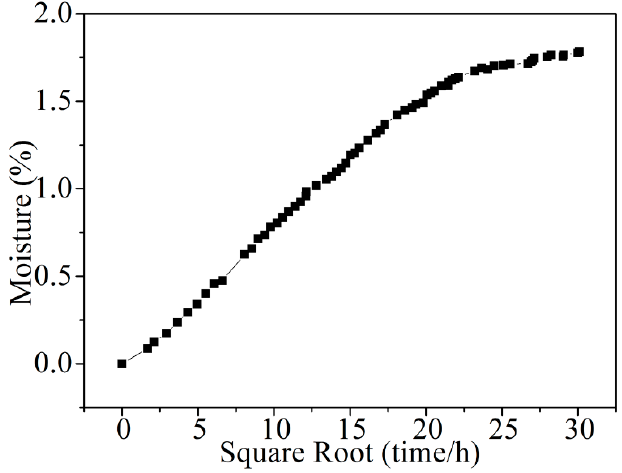
Figure 3. Moisture uptake profile of the CFRP laminates exposed to water at 70 °C.